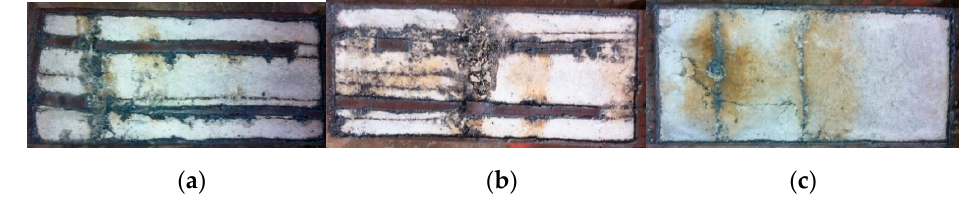
Figure 5. Damage degree of concrete core. ( a ) A-60-CF70/1.2; ( b ) B-0-CF80/1.2; ( c ) C-0-CF80/1.2.